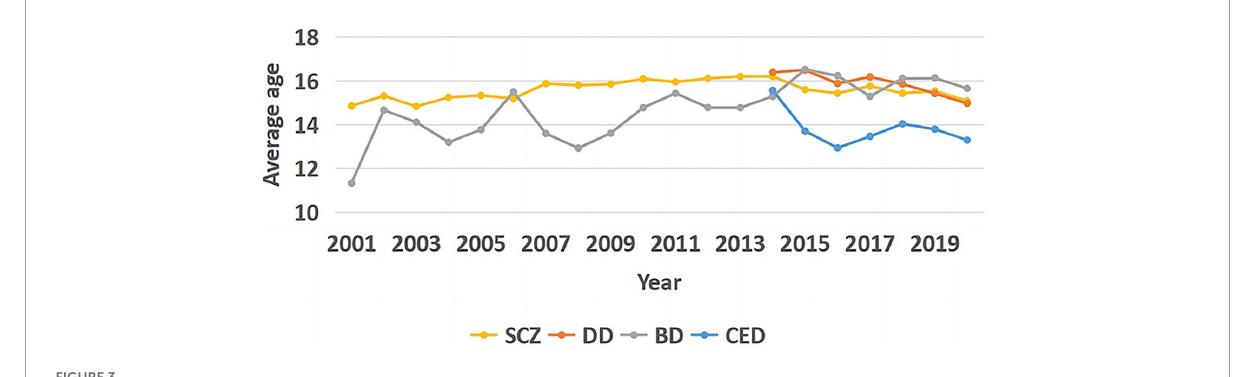
FIGURE3 Trend graph of mean age at hospitalization for the four diseases.